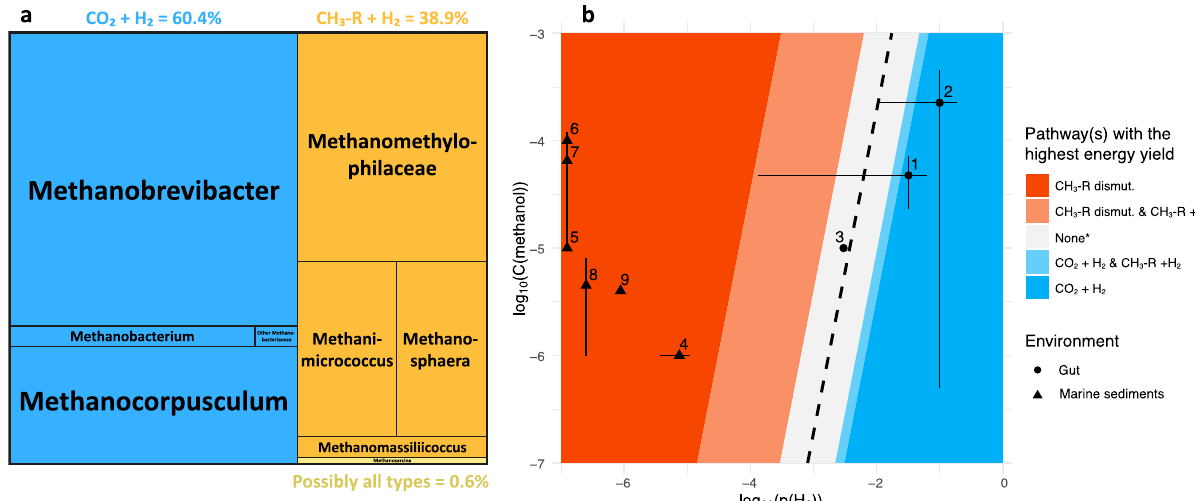
Fig. 7 Main methanogenesis pathways in the animal gut. a Proportion of the total archaeal reads that are assigned to taxa with a predicted hydrogenotrophic CO 2 -reducing methanogenesis (H 2 + CO 2 ; blue) or hydrogenotrophic methyl-reducing methanogenesis (CH 3 -R + H 2 ; orange) pathway. Methanosarcina spp. can have diverse methanogenesis pathways (i.e., the two above-mentioned pathways and the methyl-dismutation (or methylotrophic) and acetoclastic pathways). b Diagram indicating the methanogenesis pathways with the highest energy yield depending on methanol concentration (C(methanol) in mol/l) and hydrogen partial pressure (p(H 2 ) in bar). The three methanogenesis pathways considered are methyl-compound dismutation (CH 3 -R dismut.), hydrogenotrophic methyl-reducing methanogenesis (CH 3 -R + H 2 ) or hydrogenotrophic CO 2 -reducing methanogenesis (CO 2 + H 2 ). Coloured areas on the map indicate which pathway(s) yield(s) the highest amount of energy per mole of methane, i.e., concentrations and pressures for which the associated Δ G expressed in kJ/mol CH 4 is the lowest (see “ Gibbs free energies of methanogenic pathways ” in Materials and Methods). In central areas of the diagram, energy yields of two or three (*in this case none is yielding more energy) of the pathways are comparable with differences in Δ G of less than 10 kJ/mol CH 4 . This is shown in light red, grey and light blue areas. The dotted line indicates values of C(methanol) and p(H 2 ) for which all three catabolisms have exactly the same Δ G. Ranges of C(methanol) and p(H 2 ) found in the literature for rumen (1), human colon (2) and cockroach hindgut (3), and marine sediments (4 – 8; Supplementary Table 3) were mapped on the graph: dots correspond to mean values and bars indicate minimal and maximal